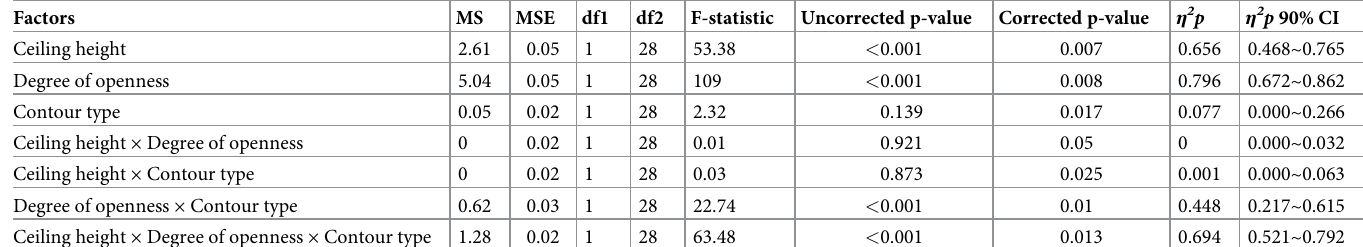
Table 2. ANOVA results for pleasantness ratings.